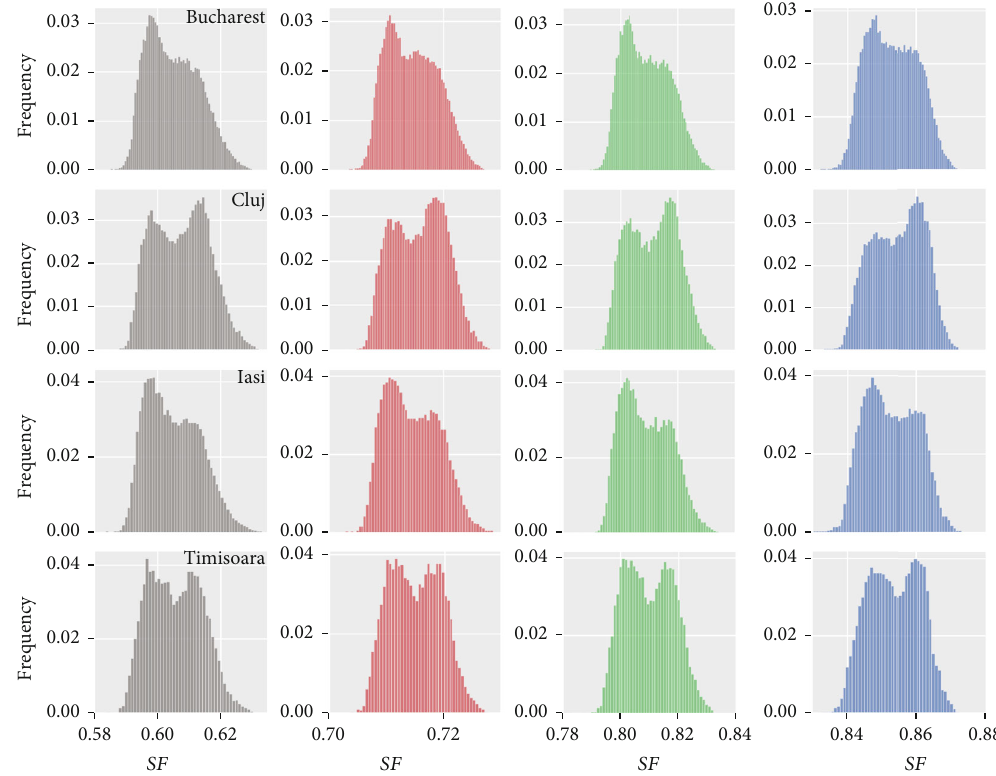
Figure 6: Distribution of spectral factor (broken down in 30 classes) evaluated over 2012-2020 for the four colored solar cells considered in this study. The computation was done assuming the cells operating in the main four urban areas in Romania. The distribution color corresponds to the cell color except the white cell for which SR ð λ Þ is displayed in